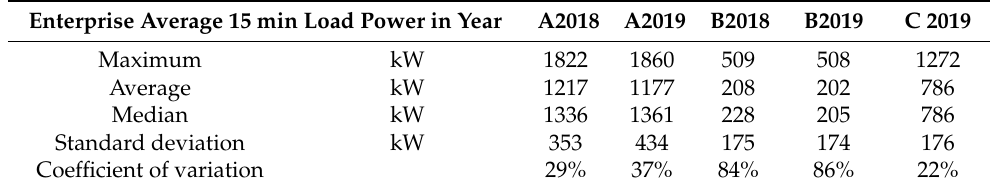
Table 3. Statistical data of the 15 min load power time series of the enterprises.